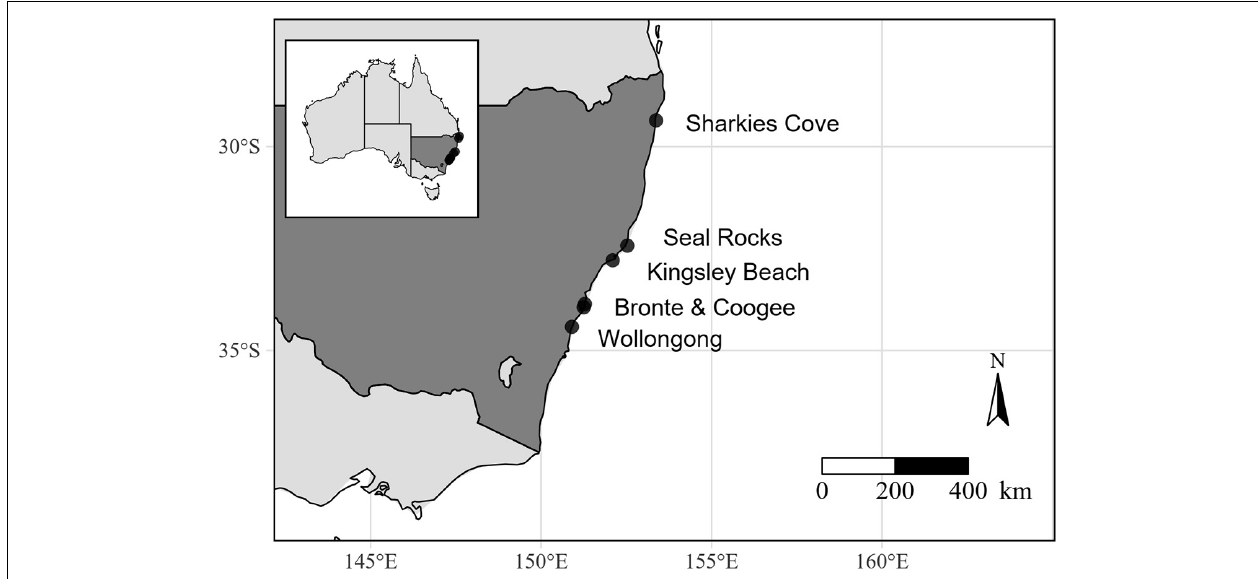
FIGURE 1 | Location of six sites surveyed for Caulerpa filiformis recruits and their habitat associations in New South Wales (dark gray), Australia.